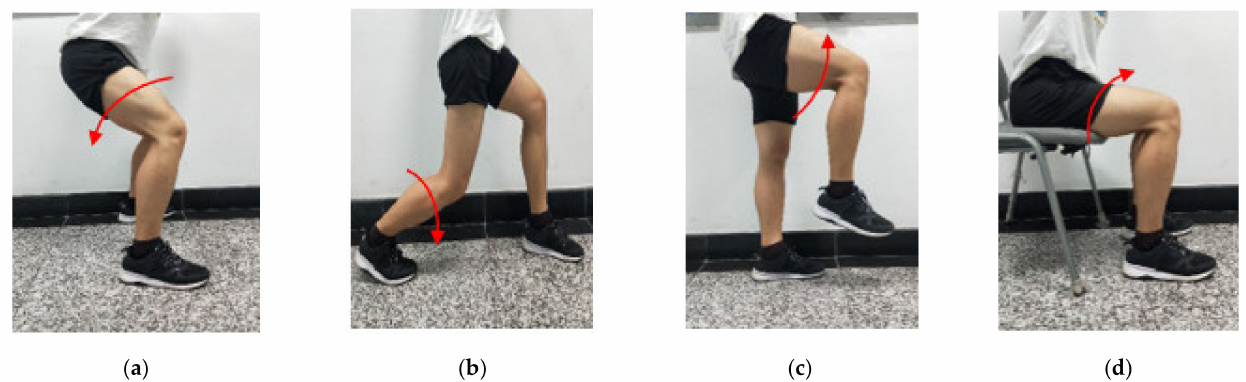
Figure 15. Four movements of the lower limb. ( a ) Squatting; ( b ) lunging; ( c ) raising the leg; ( d ) standing up. The figures below indicate the angle changes of the thigh and calf in a movement cycle. As can be seen from Figure 16a,b, the 4 movements are mainly the change of thigh angle. Their change trend is the same but there is some difference at the maximum value; the highest is in the raise leg movement (107 ◦ ), the second is stand up (98 ◦ ), the third is squat (76 ◦ ), and the lowest is the lunge (61 ◦ ). There was no obvious regularity in the changes of calf angle; only the lunge had the largest range ( − 53 ◦ ).